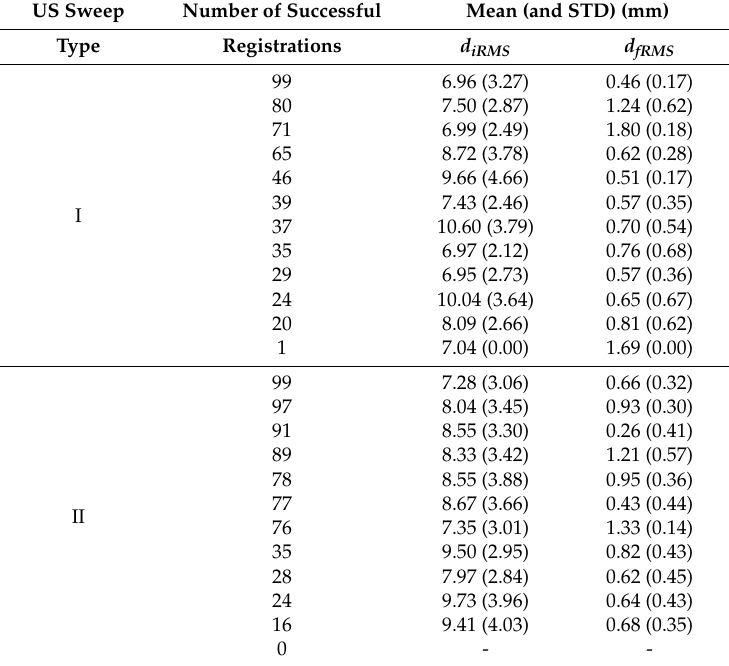
Table 1. Number of successful registrations and the mean root-mean-square (RMS) TRE (i.e., mean di RMS and mean df RMS ) values for each US sweep averaged over all successful registrations in Test I. For each registration, di RMS and df RMS describe how far a volume is away initially and after registration from its assumed optimum, respectively.